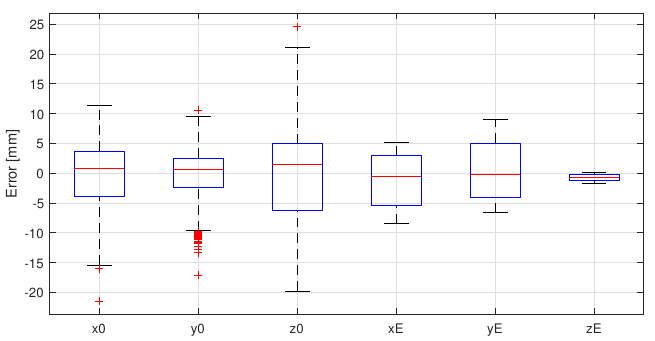
Figure 12. Errors for the identified values based on experiment